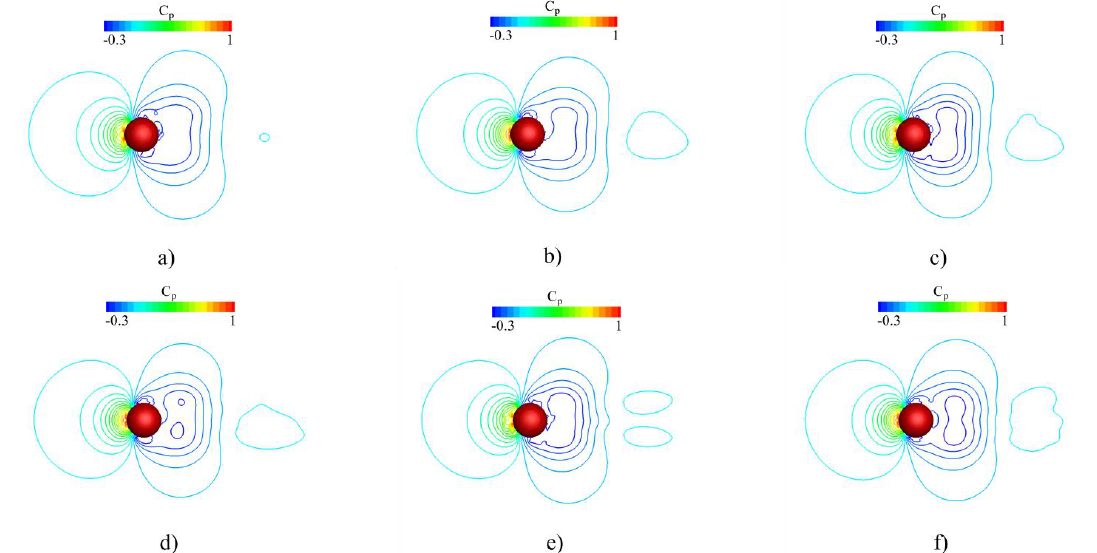
Figure 6. Variation of lift coefficient at Re = 300.